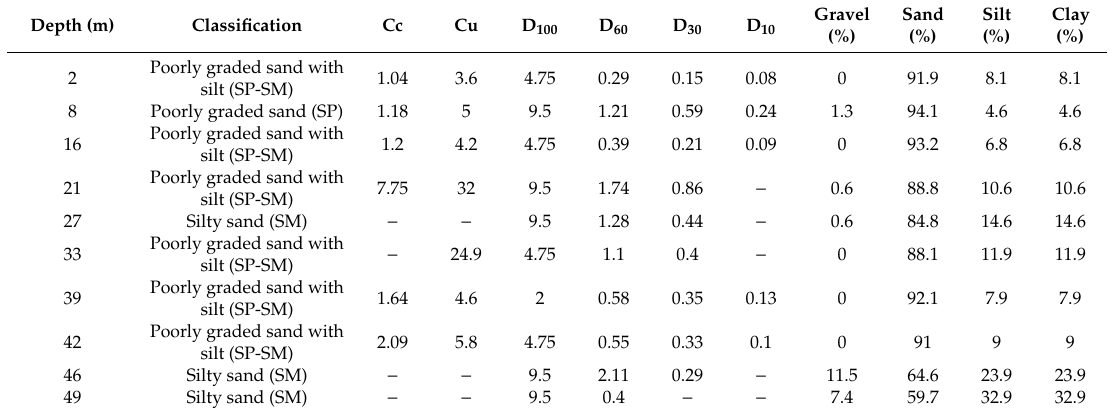
Table 2. Sieve test and grain number (Al-Khobar).